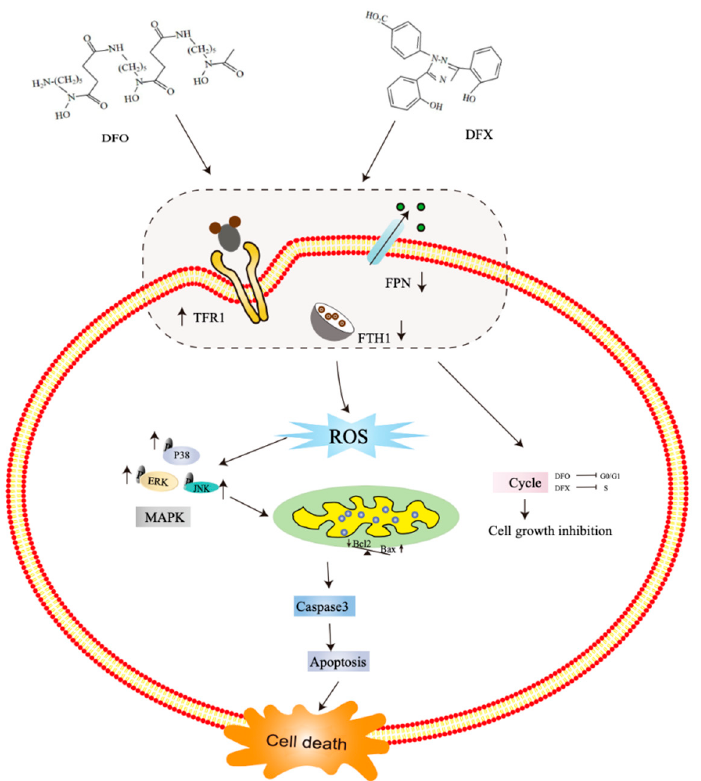
Figure 9. A schematic diagram of the effect of iron chelators on osteosarcoma cells. DFO and DFX altered iron metabolism, released ROS, the activation of the MAPK pathway; DFO induced G0/G1 cell-cycle arrest, DFX induced S cell-cycle arrest, and both iron chelators triggered apoptosis in osteosarcoma cells. These processes induce osteosarcoma cell death.